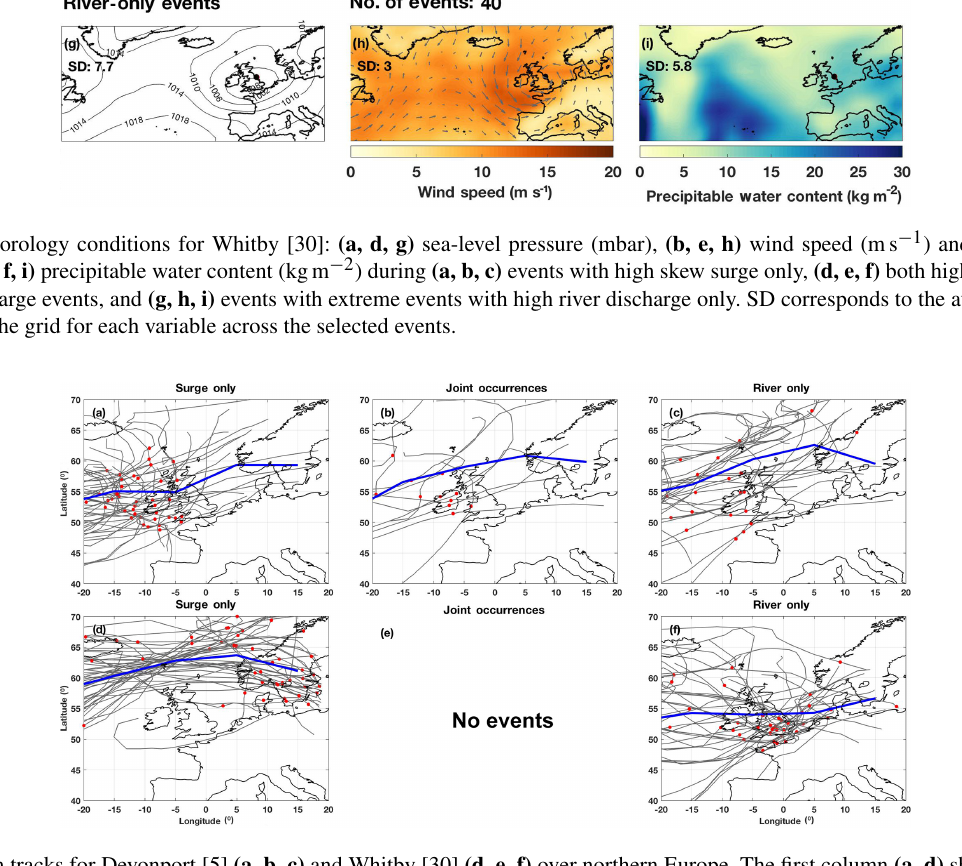
Figure 9. Storm tracks for Devonport [5] (a, b, c) and Whitby [30] (d, e, f) over northern Europe. The first column (a, d) shows events with high skew surge only. The second column (b, e) both high skew surge and high river discharge events. The third column (c, f) shows events with high river discharge only. The blue line represents the mean storm track. Grey lines show individual storm tracks, with the location of the storm at peak skew surge and/or peak river discharge shown by the red